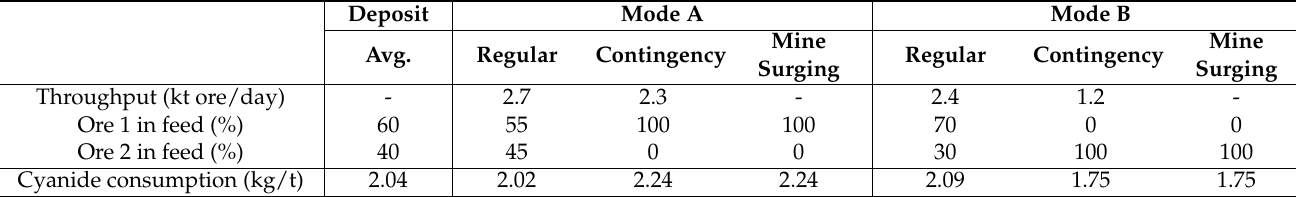
Table 2. Description of operational modes in relation to possible deposit forecast, considering high and low CN consuming ore which correspond to Ore 1 and Ore 2,